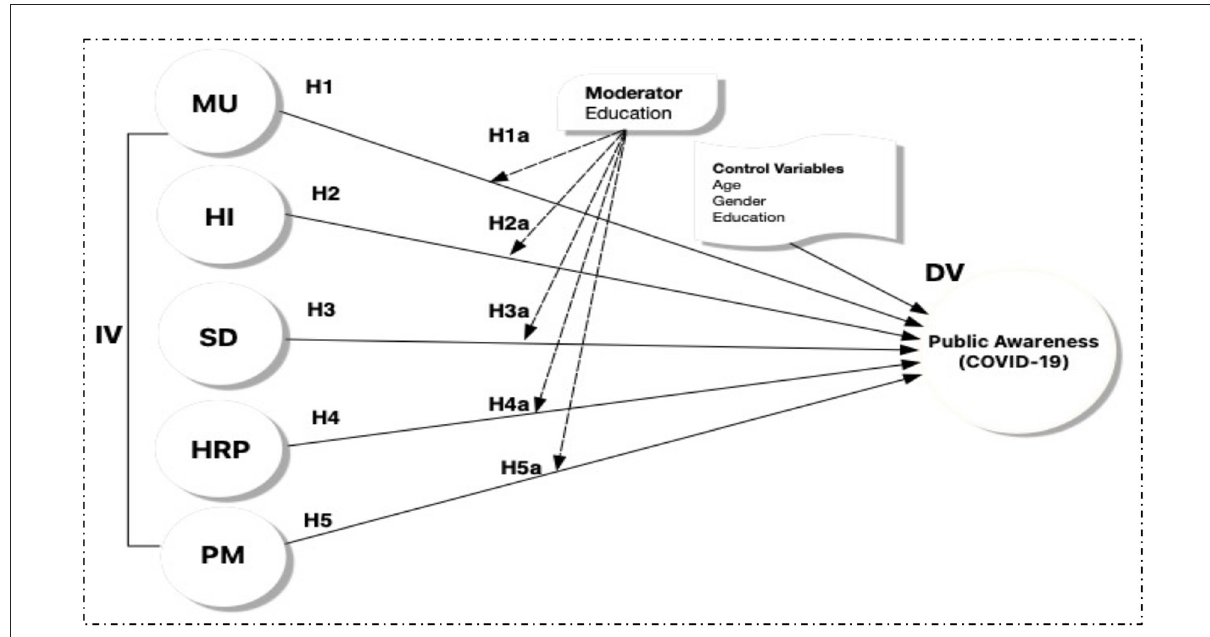
FIGURE1 Hypothesis model: MU, mask usage; PH, personal hygienic; SD, social distance; HRP, health risk perception; PM, protective measures; PA-COVID, public awareness about